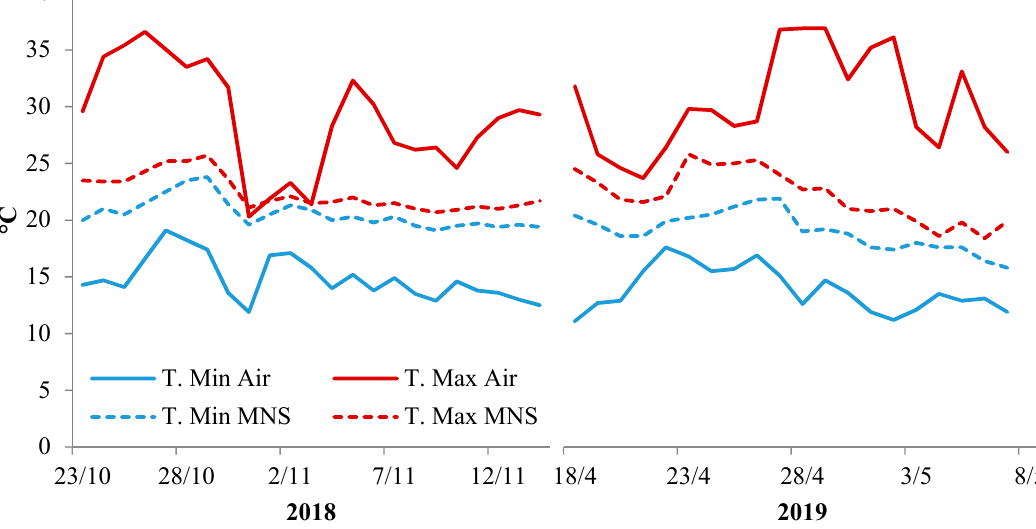
Figure 2. Daily average maximum and minimum temperatures of the air and mineral nutrient solutions (MNS) inside the greenhouse during autumn 2018 and spring 2019 cultivations.